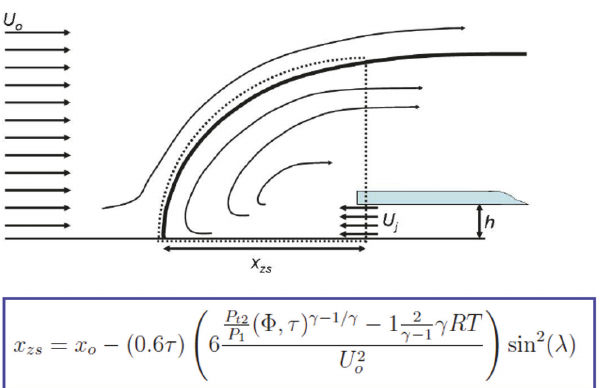
Figure 10: The simplified model of axial momentum balance on casing and its vicinity (illustrated based on the information in [15]). Figure reproduced from BENNINGTON et al.